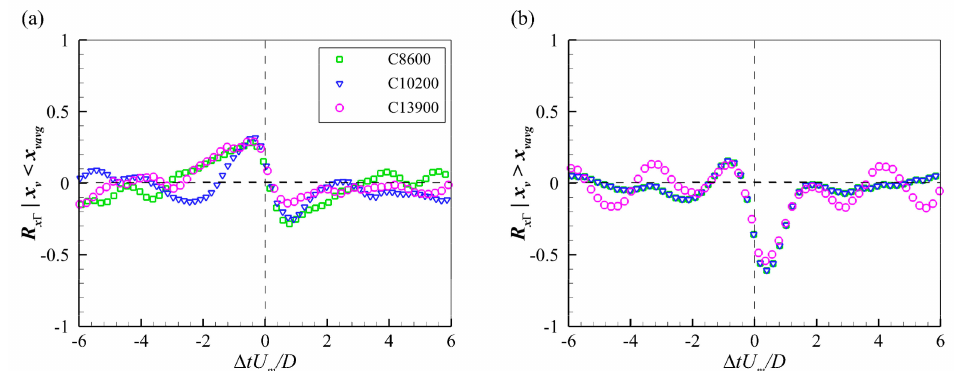
Figure 13. Conditional correlation functions between streamwise position and circulation strength of PHVs locating at ( a ) upstream and ( b ) downstream of their time-averaged streamwise